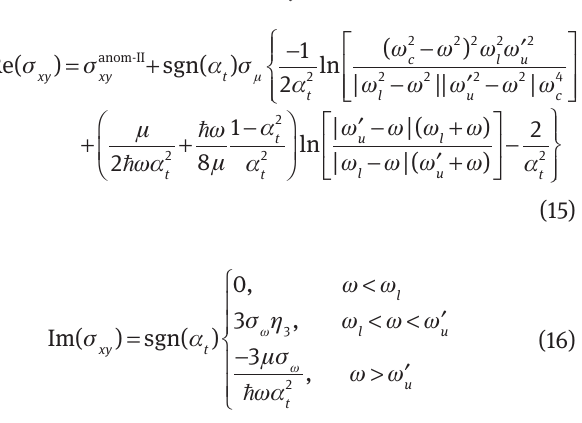
> 0 and (B) α < 0. (C) Real and (D) imaginary parts of optical conductivities σ t t = 2 e 2 /h 0